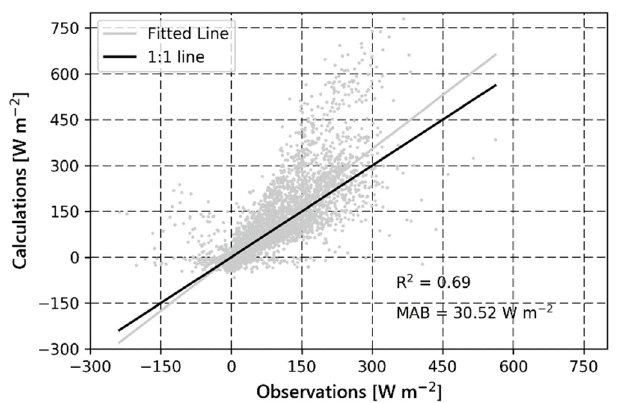
Figure 4. Latent Heat Flux estimated via the Penman-Monteith equation compared to observations (correlation is found to be significant with p < 0.01).